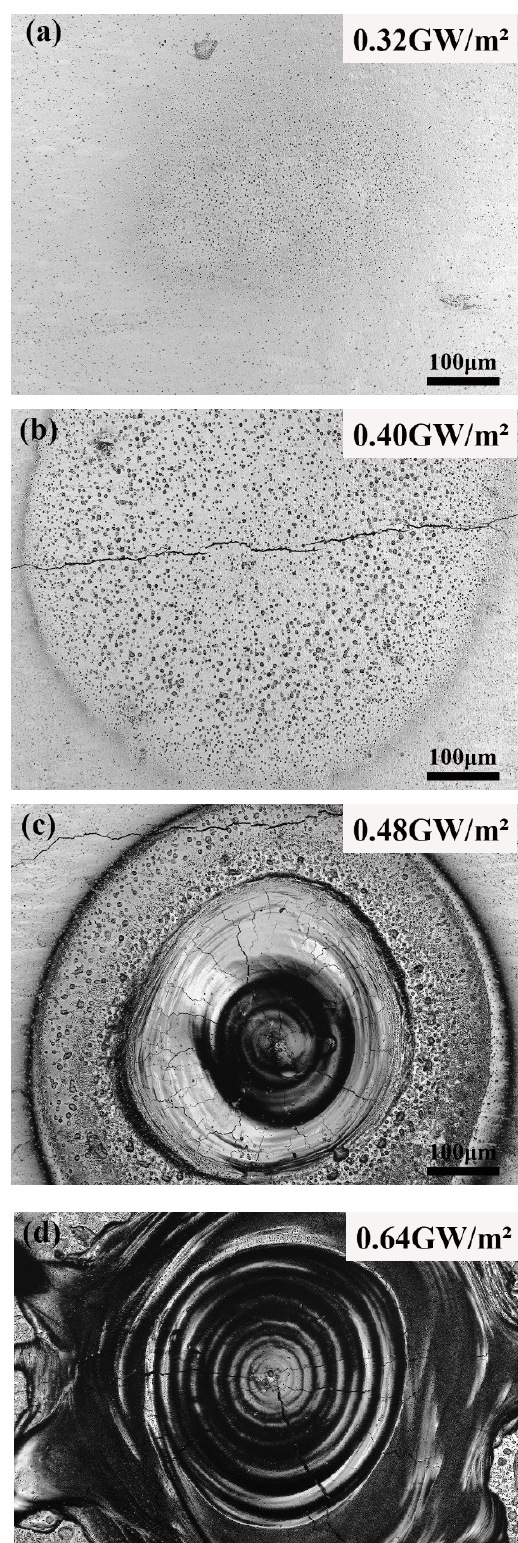
8 of 18 Figure 5. Surface morphologies of WY50 samples under different laser thermal shock power densi- ties: rolled samples ( a – d ); fully recrystallized samples ( e – h ). Figure 6 exhibits the local surface morphologies from Figure 5 of thermal shock sam- ples. Only one crack along the rolling direction appears on the surface of the rolled sample at a power density of 0.40 GW/m 2 , while the cracks along the RD direction begin to bifur- cate, and secondary cracks can be observed on the surface of the fully recrystallized sam-